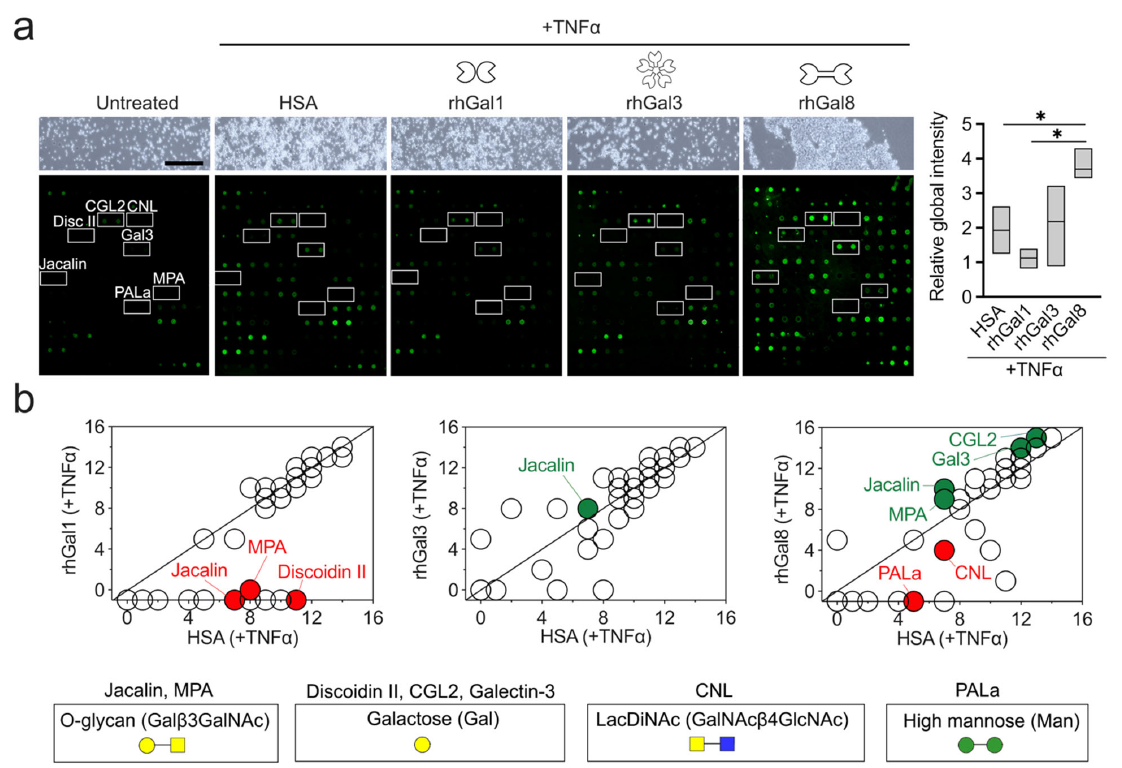
Figure 1. Galectins differentially regulate the surface glycosylation of human monocytes. ( a ) Human primary CD14 + CD16 − monocytes were treated with TNF α in the presence of human serum albumin (HSA) or recombinant human galectins (rhGal1, rhGal3, rhGal8) for 30 min. Untreated monocytes were used as control. Cell surface proteins in each condition were isolated and probed by lectin array (n = 3 independent donors). The data are presented as floating bars (min. to max.) with the line at the median. Significance was determined using one ‐ way ANOVA with Greenhouse–Geisser cor ‐ rection. Scale bar, 250 μ m. ( b ) Scatterplot comparing the binding signals derived from images in ( a ). Data were normalized to untreated monocytes. The green and red dots indicate a statistically sig ‐ nificant increase or decrease in binding intensity. Significance was determined using the ratio of paired t ‐ test. *, p < 0.05.